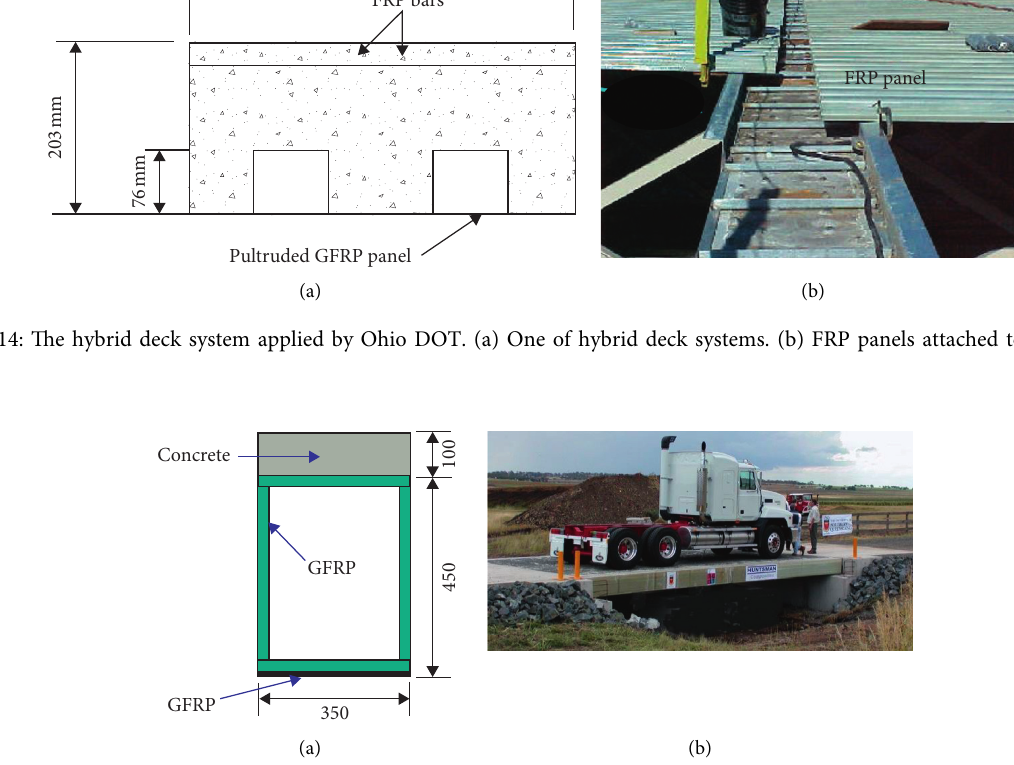
Figure 15: The hybrid beam system applied in Australia. (a) The cross-section of the hybrid beam (unit: mm). (b) Field testing of the bridge.